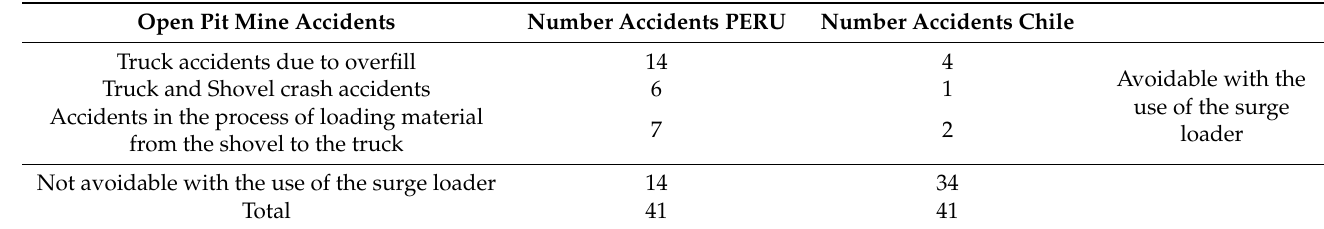
Table 3. Avoidable